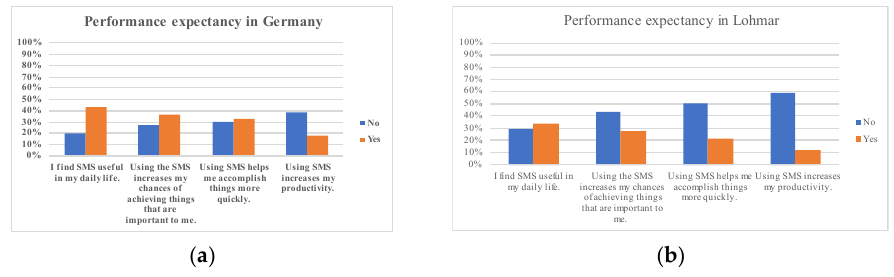
Figure 5. Performance Expectancy (PE): ( a ) Germany vs. ( b ) Lohmar.